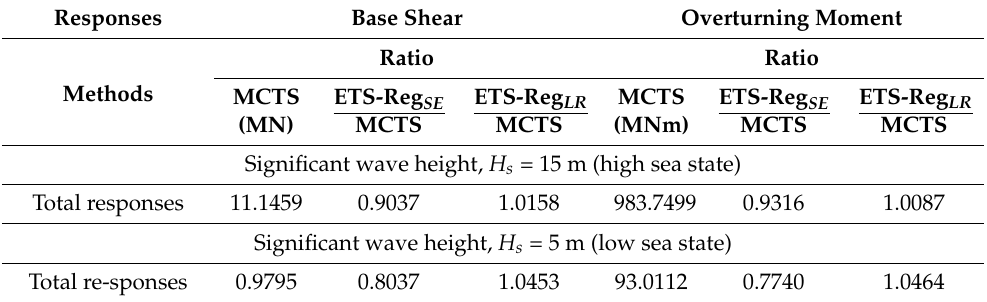
Table 4. Comparison of the MCTS method with the ETS-Reg SE and ETS-Reg LR models for 100-year responses with the low and high sea state ( H s ) conditions without current ( U = 0.0 m/s) impacts.